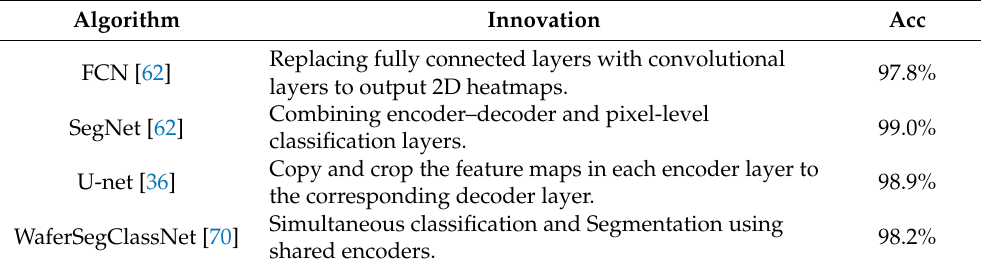
Table 5. Segmentation network model